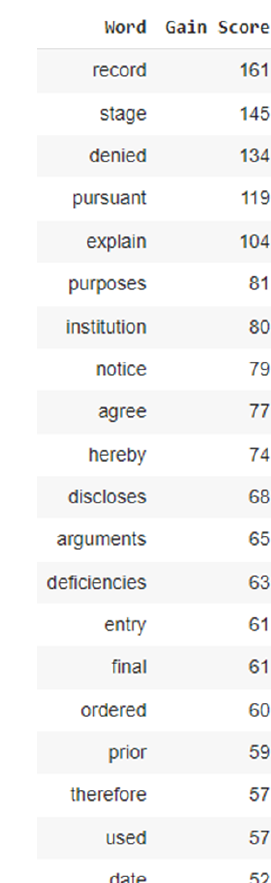
Figure 5. Summary plot of the highest ranking words obtained using SHAP ( left ) and the highest ranking words identified by the gain score metric in XGBoost ( right ) in the test set for written decision classification. The SHAP plot shows clouds of points representing individual documents; a positive SHAP value indicates a contribution to a positive classification, i.e., denial, and a negative value a contribution to a classification as a